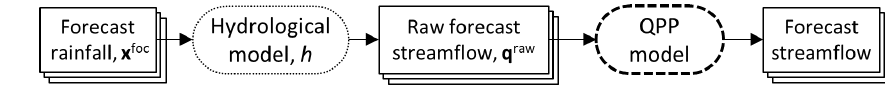
Figure 1. Illustration of general approach used to produce streamflow forecasts. Layers represent ensemble members.